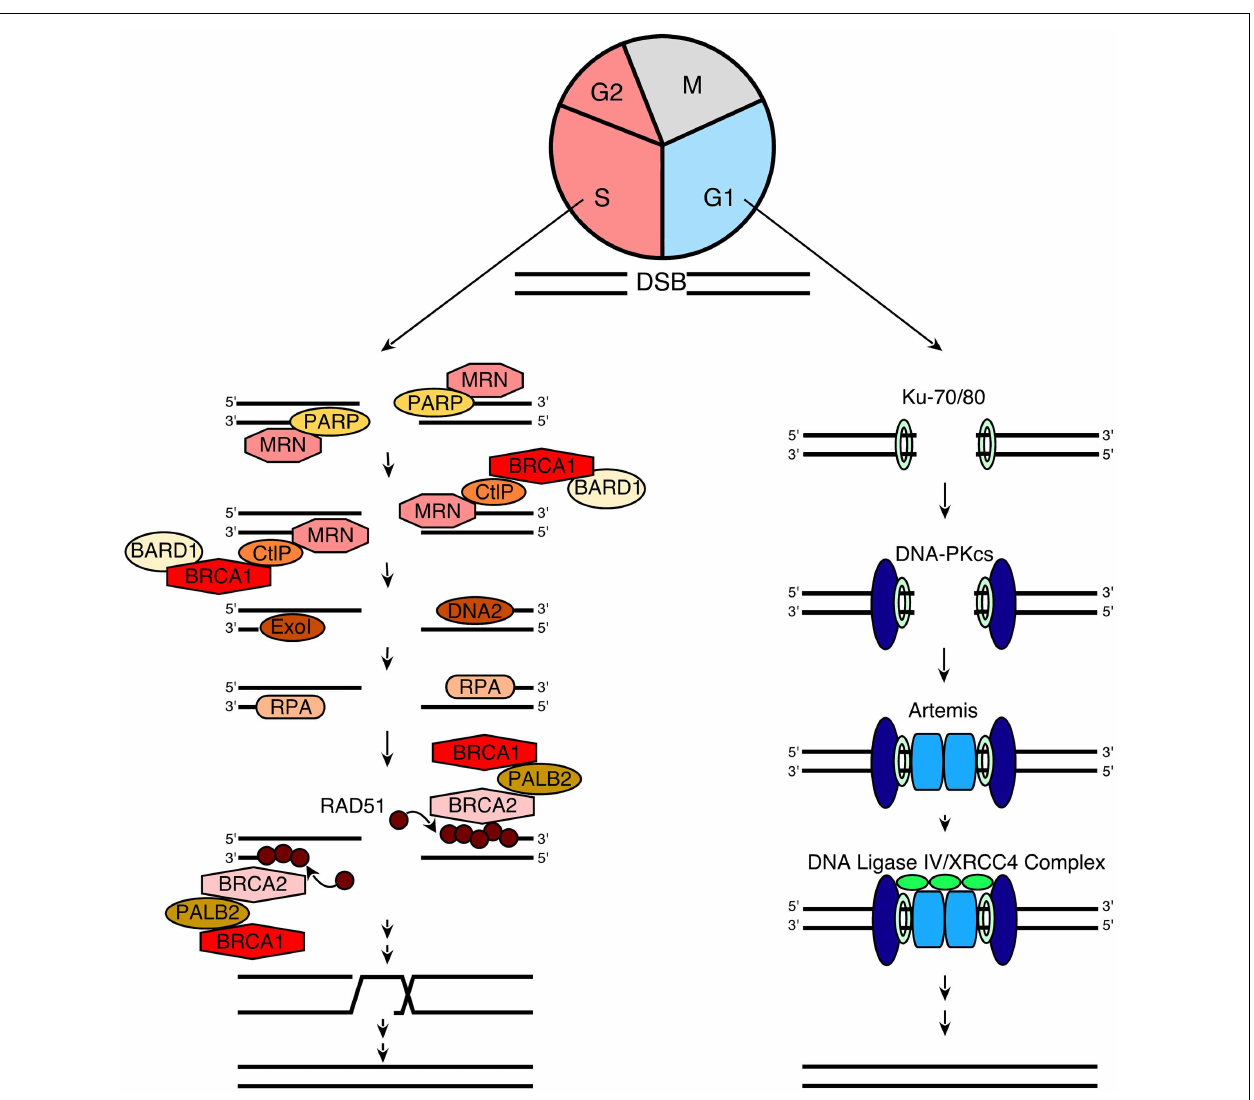
binding to DNA ends (67); (2) the MRN complex is recruited (66) to the DSB (together with CtIP and BRCA1/BARD1) and mediates the initial stages of DSB resection; (3) extensive end resection is catalyzed by EXO1 and DNA2/BLM (79, 80), resulting in long stretches of ssDNA; (4) this ssDNA is coated by RPA; (5) the BRCA2/PALB2/BRCA1 complex facilitates replacement of RPA with Rad51 (73, 81); (6) RAD51 filaments induce strand invasion into homologous DNA sequences; (7) DNA polymerization occurs using the sister chromatid as a template; and (8) resolution of the resulting complexes produces an exact copy of the template where the DSB was generated. Additional details of the HR process can be found in Refs. (60, 72,